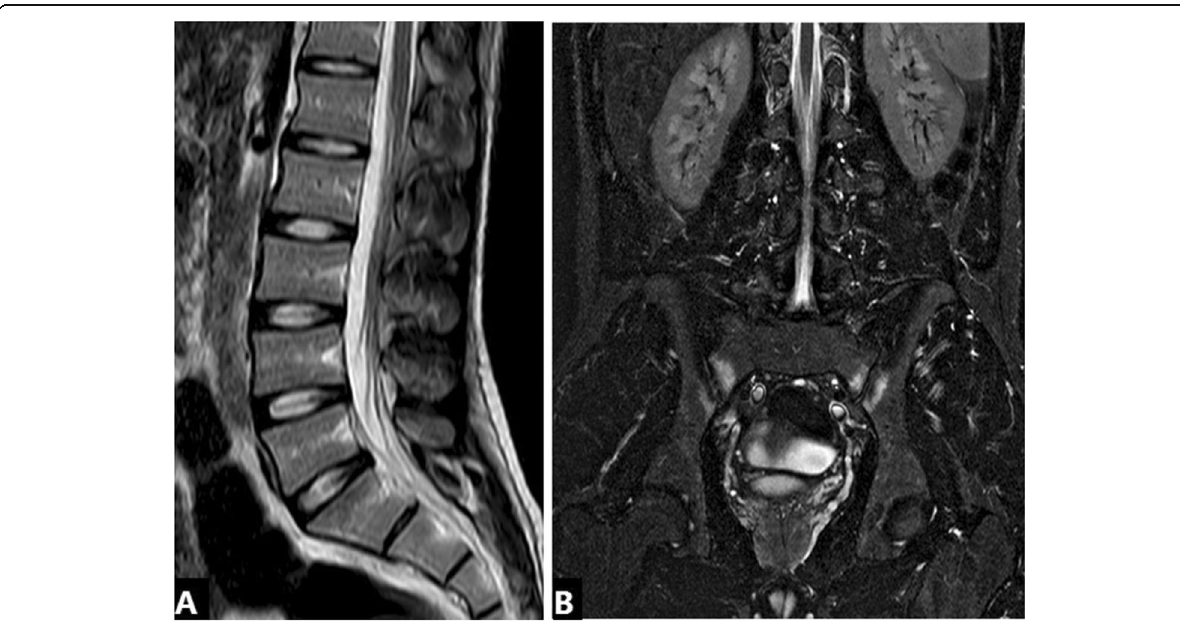
Fig. 2 A 24-year- old male patient, presenting with low back pain. a Routine MR protocol images are normal. b Additional coronal STIR images revealed subchondral edema in the inferior aspects of both sacroiliac joints denoting bilateral